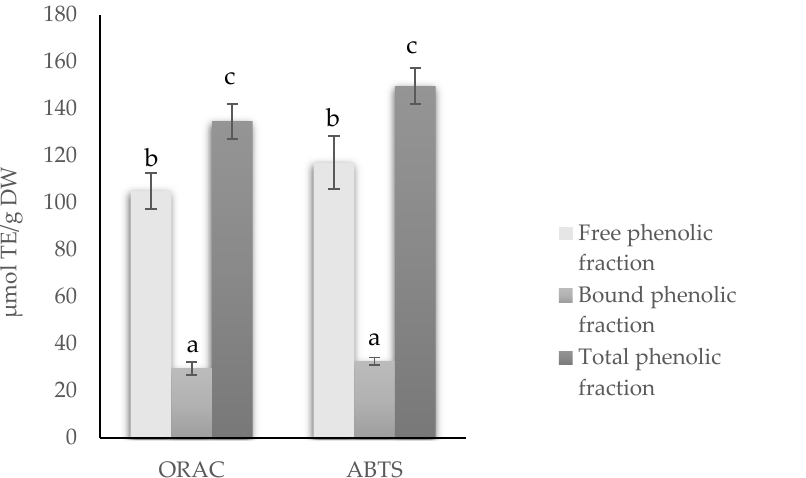
Figure 1. Antioxidant activity of free, bound and total phenolic fraction of red lentil hulls. Data are expressed as µmol Trolox equivalents (TE)/g dry weight. Error bars represent standard deviation (n = 6). Different letters denote statistical differences among free, bound and total phenolic fractions ( p ≤ 0.05). Abbreviations: ABTS, 2,2 ′ -azino-bis-3-ethylbenzothiazoline-6-sulfonic acid; ORAC, oxygen radical absorbance capacity; TE: Trolox equivalents; DW: dry weight.